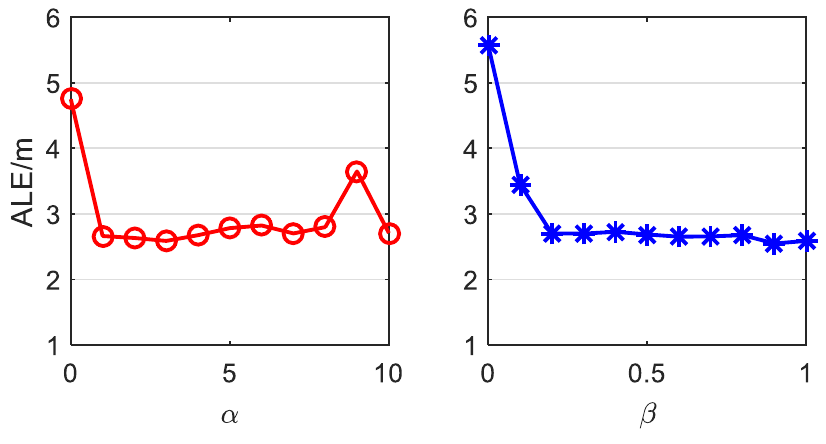
Figure 7. ALEs versus different α and β